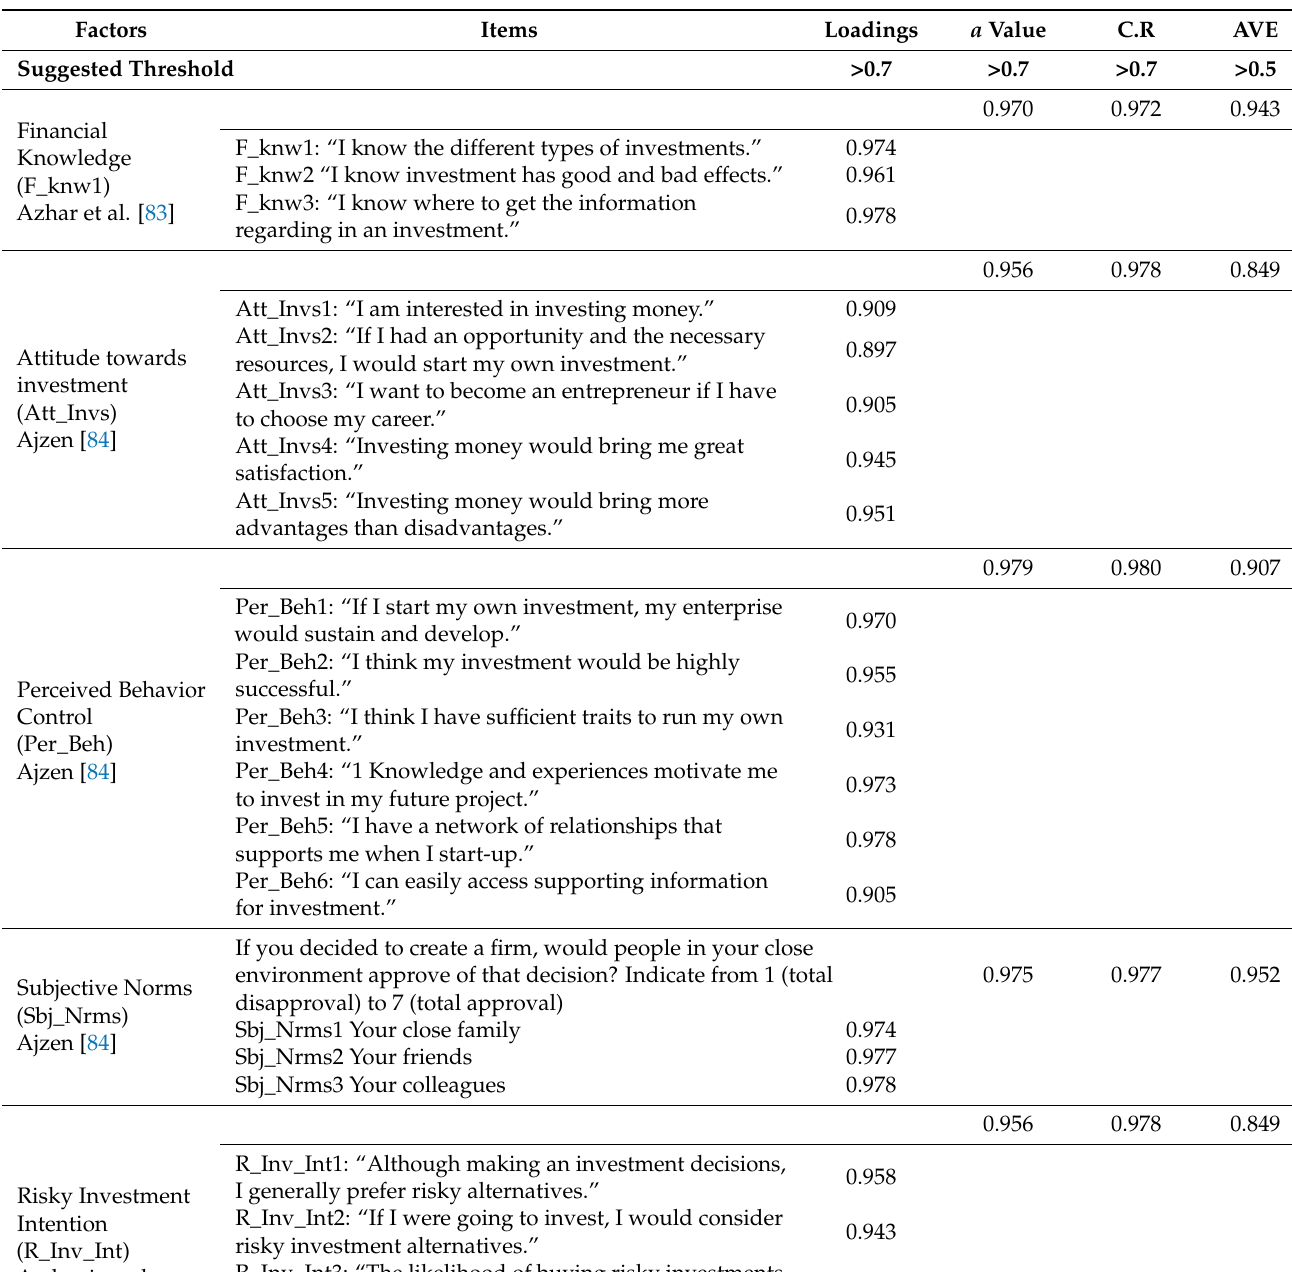
Table 1. The Scale Psychometric Properties